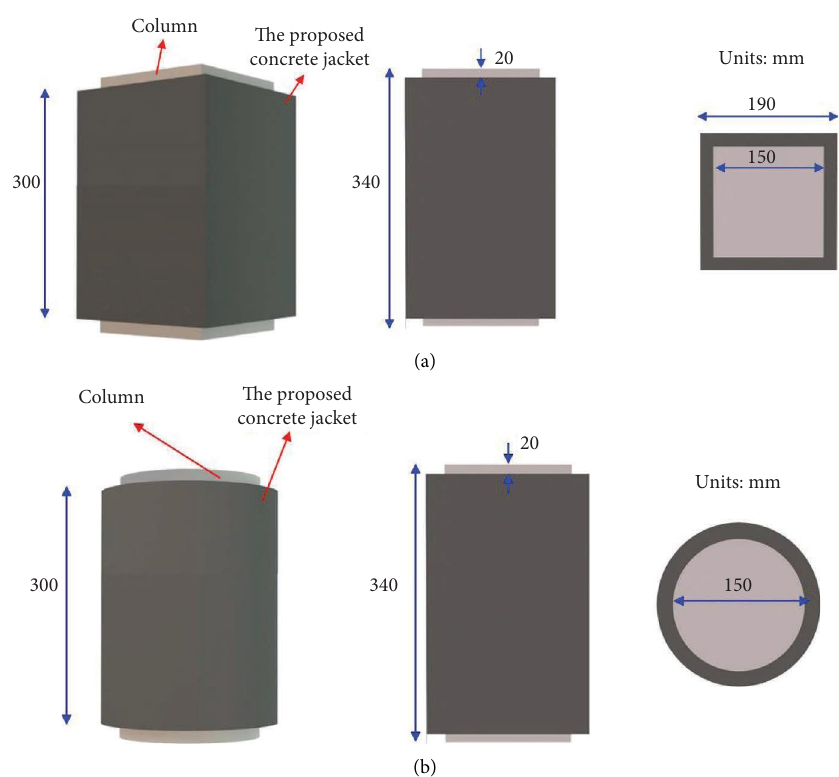
Figure 3: Geometric characteristics of the studied columns: (a) square section and (b) circular section. Table 3: Chemical characteristics of the binder materials.